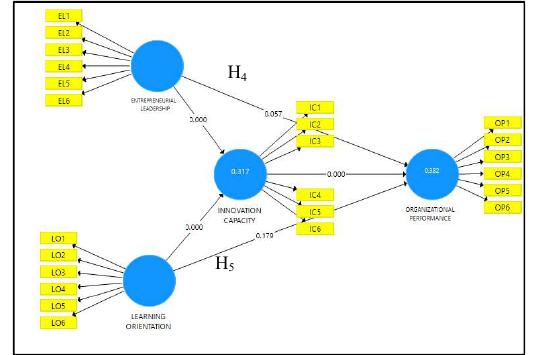
Fig. 3. Path Coefficients for Direct Effects (H 1 , H 2 and H 3 ) Fig. 4. Path Coefficient for Indirect Effects (H 4 and H 5